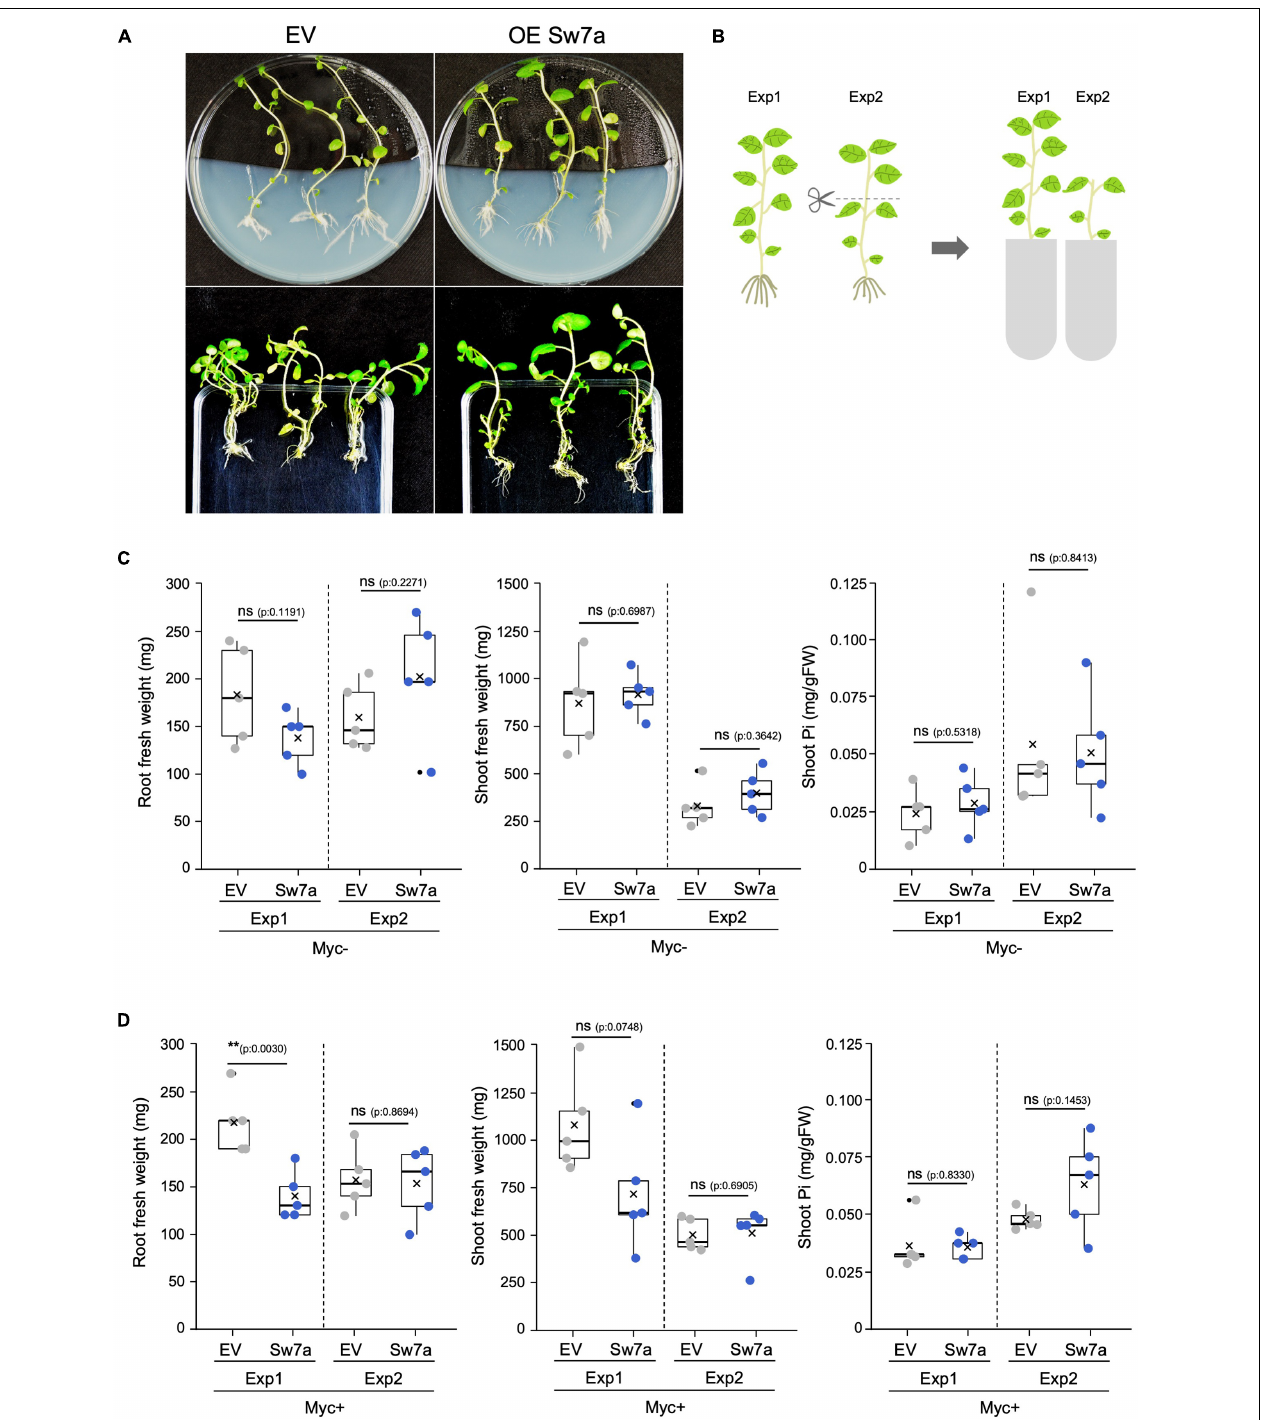
FIGURE 4 | Effect in plants of the ectopic expression of StSWEET7a . (A) Ectopic expression of StSWEET7a in roots of composite potato plants modified shoot development as compared with plants transformed with an empty vector (EV). StSWEET7a expressing plants had larger leaves and less branches than EV plants before transplanting to pots. (B) Graphic representation of how Exp1 and Exp2 were carried out. Plants in both experiments were transplanted 4 weeks after transformation. In Exp1 plants were directly transplanted to pots, while in Exp2 plant shoots were excised right before transplanting. Plant growth parameters at the end of each experiment under non-mycorrhizal (Myc–) (C) and mycorrhizal (Myc+) conditions (D) . Five biological replicates ( n = 5) were used for each treatment. Statistical significance (calculated as explained in section “Materials and Methods”) is shown with exact p -values and with asterisks, ns, non-significant, p > 0.05; * p < 0.05; ** p <